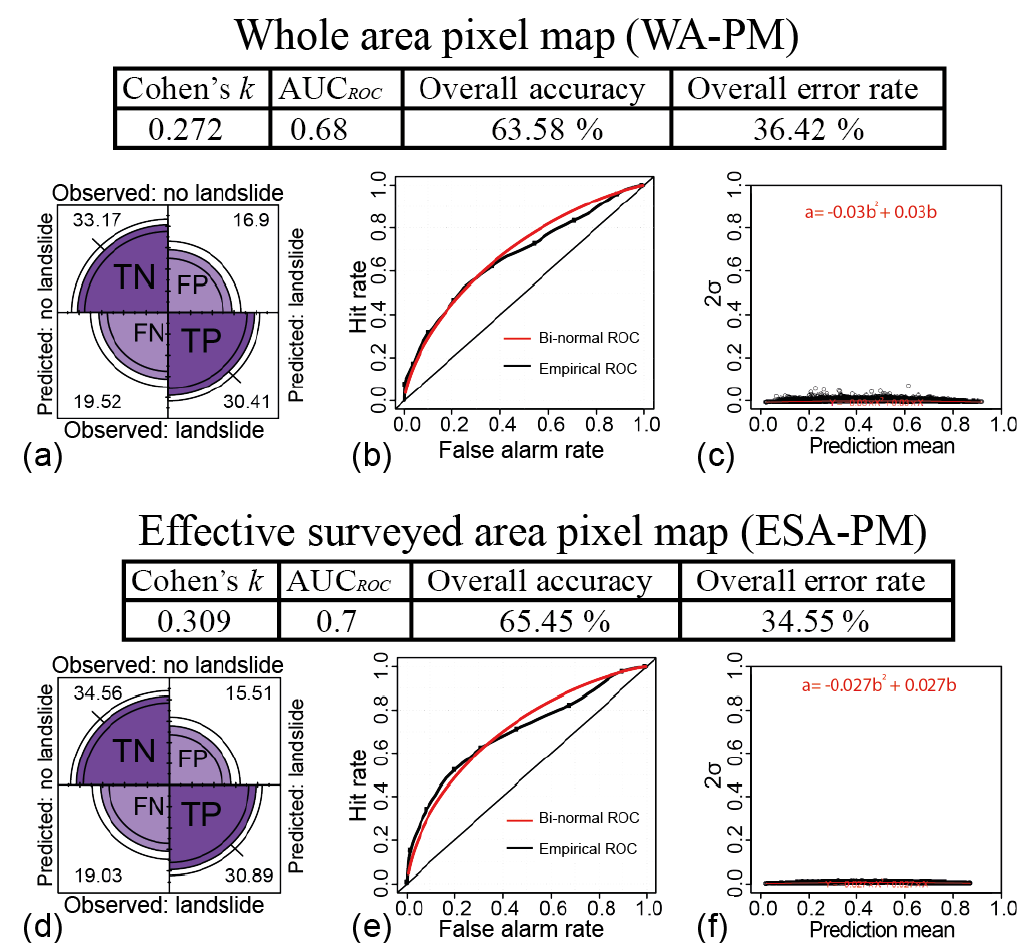
Figure 3. Pixel-based LR models prediction performance results: summary tables of the Cohen’s kappa index, area under the ROC curve (AUC), overall accuracy ((TP + TN) / (TP + TN + FP + FN)) and overall error rate ((FP + FN) / (TP + TN + FP + FN)). (a, d) Four-fold or contin- gency plots; (b, e) ROC curves; (c, f) classification error plots and the quadratic regression fit curves (red